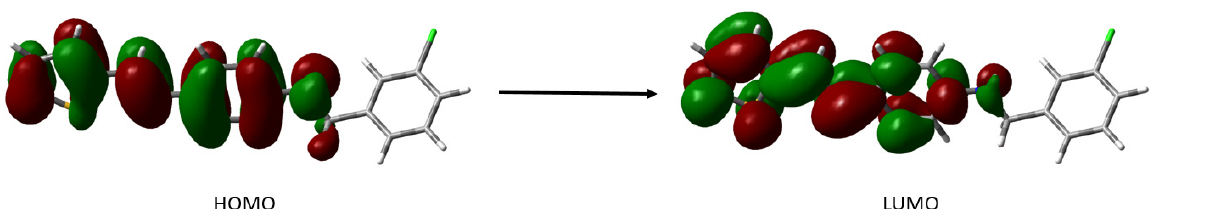
Figure 9. Canonical molecular orbitals involved in transition in UV-Vis spectra of compound trans - 5 .